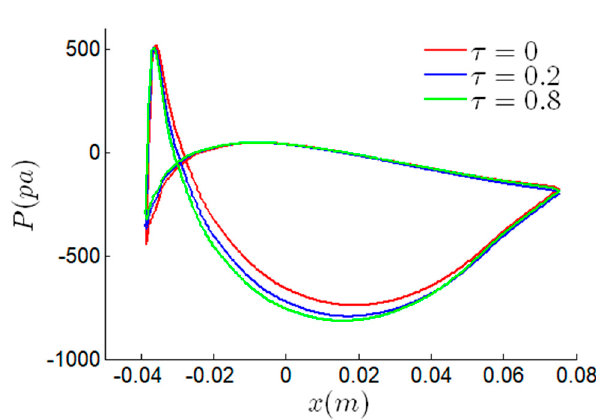
Figure 11. The snapshots of the vorticity contours and velocity contours for 𝑓 ∗ = 0.68 , 𝜃 (cid:2868) = 60 ° , 𝑡 = 15.15𝑇 , ( a ) 𝜏 = 0 , ( b ) 𝜏 = 0.2 , ( c ) 𝜏 = 0.8 .